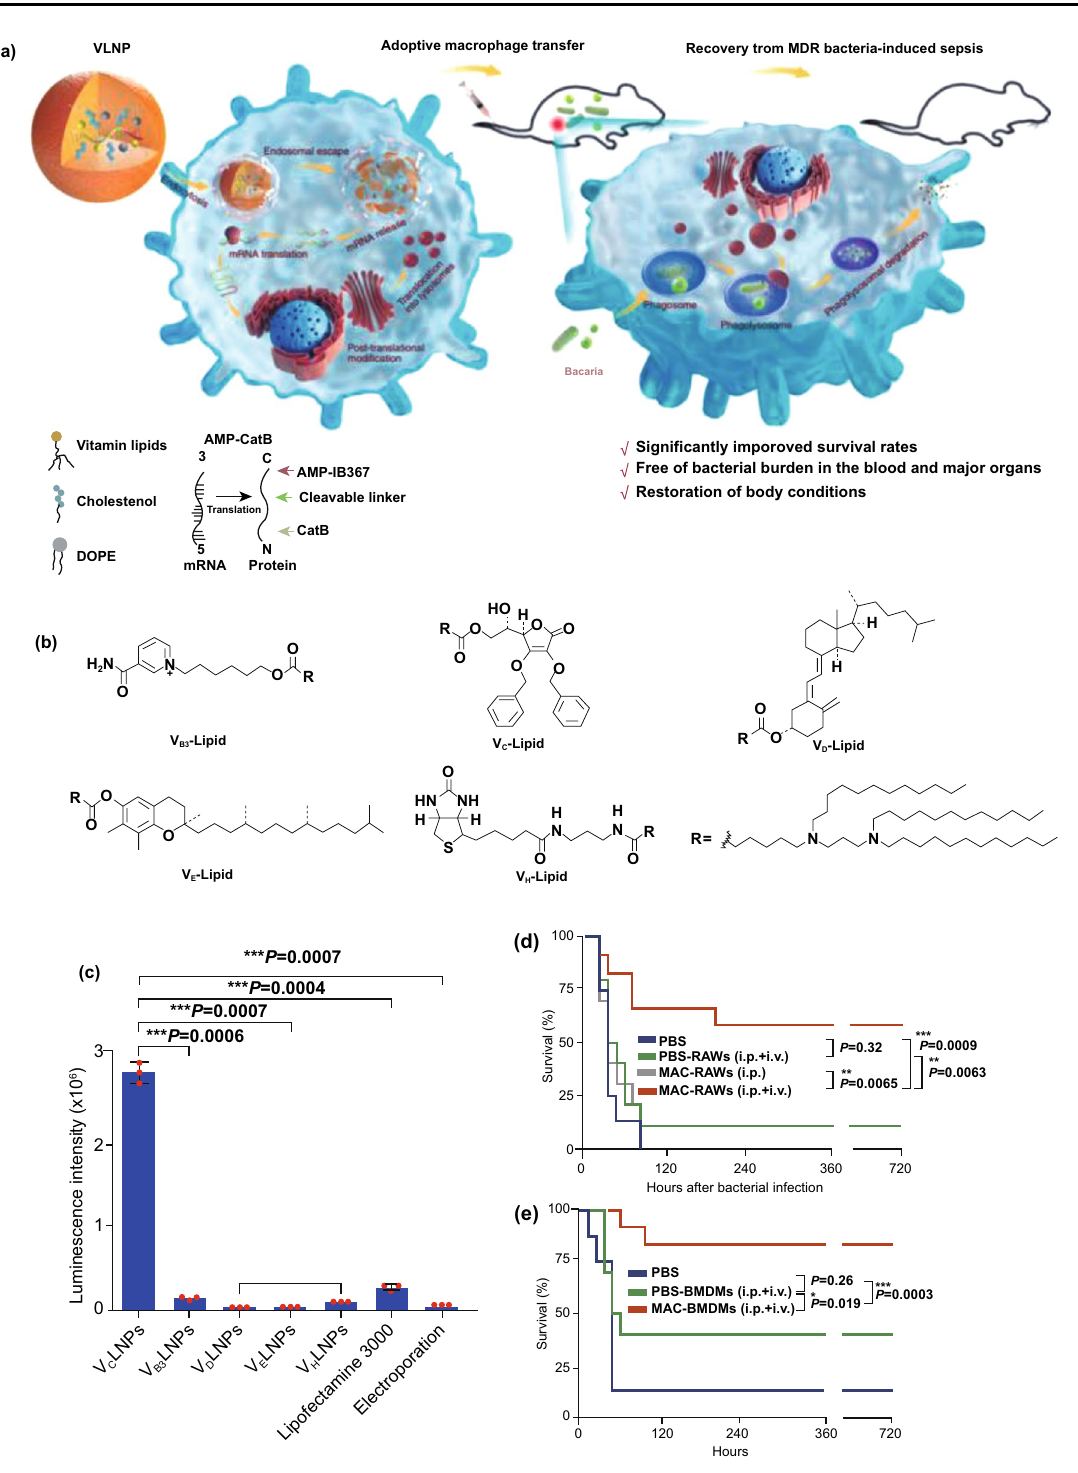
Fig. 13 Vitamin lipid nanoparticle-guided AMP-CatB mRNA delivery restores the innate immune ability of macrophages for the treatment of multidrug-resistant bacterial sepsis complicated by immunosuppression. a Schematic illustration of the therapeutic mechanism of MACs mediated by VLNP delivery. b Chemical structures of vitamin-derived lipids, including V B3 -lipid, V C -lipid, V D -lipid, V E -lipid and V H -lipid. c mRNA delivery efficiency of various VLNPs in RAW264.7 cells compared with Lipofectamine 3000 and electroporation. d Survival rates of bacterial inoculation-induced septic mice undergoing treatment with PBS, PBS- RAWs and MAC-RAWs. e Survival rates of bacterial inoculation-induced septic mice undergoing treatment with PBS, PBS-BMDMs and MAC-BMDMs. Repro- duced with permission from Ref. [226]. Copyright 2020 Nature Publishing